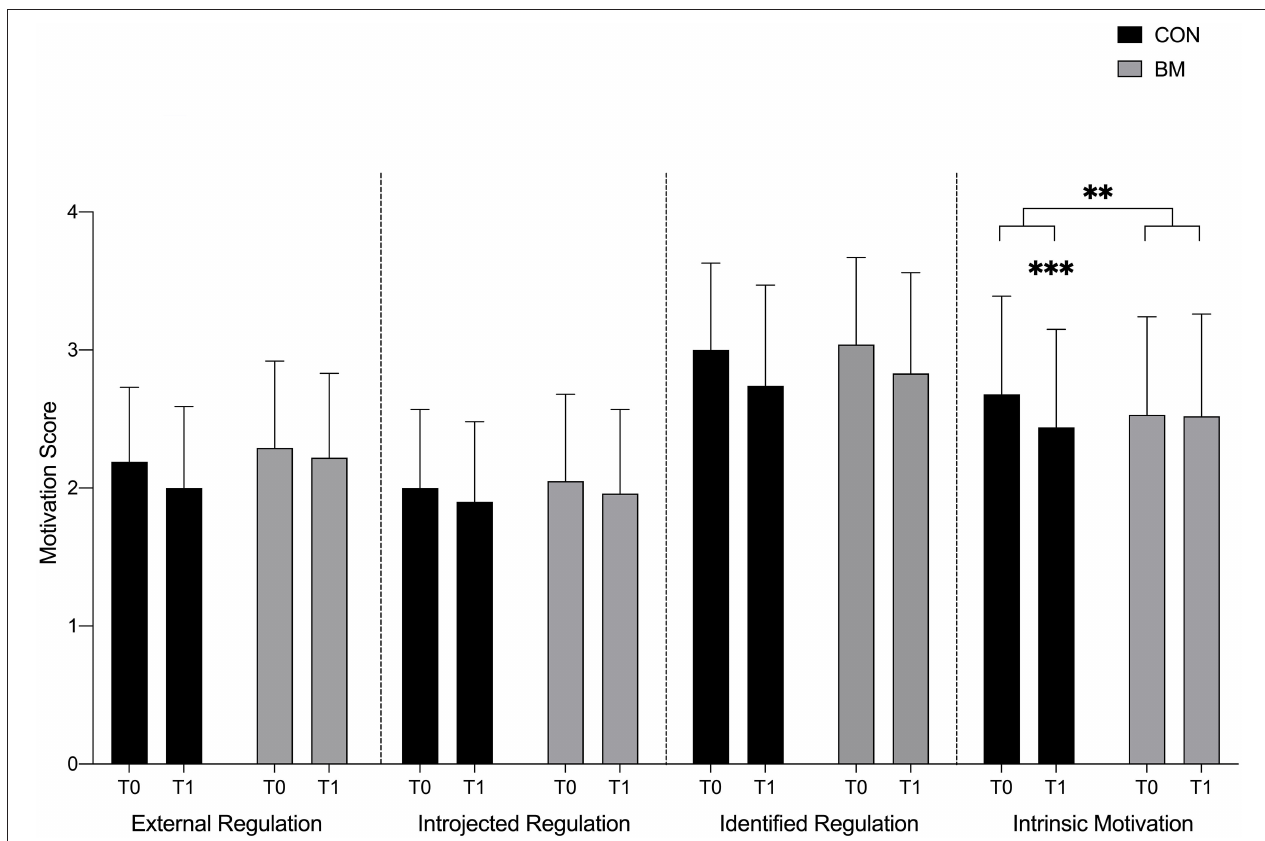
FIGURE 4 | Motivation (SRQ-A) for Classroom-based Mathematics for the two Intervention Groups (CON, BM) at T0 and T1. Motivation for classroom-based mathematics before (T0) the 6 weeks intervention period and after (T1) for the four motivation types; External Regulation, Introjected Regulation, Identified Regulation, and Intrinsic Motivation. A significant decrease in intrinsic motivation ( p < 0.001, ***) was seen from T0 to T1 for CON, and a significant interaction was found for BM compared to CON from T0–T1 ( p = 0.006, **) for intrinsic motivation.